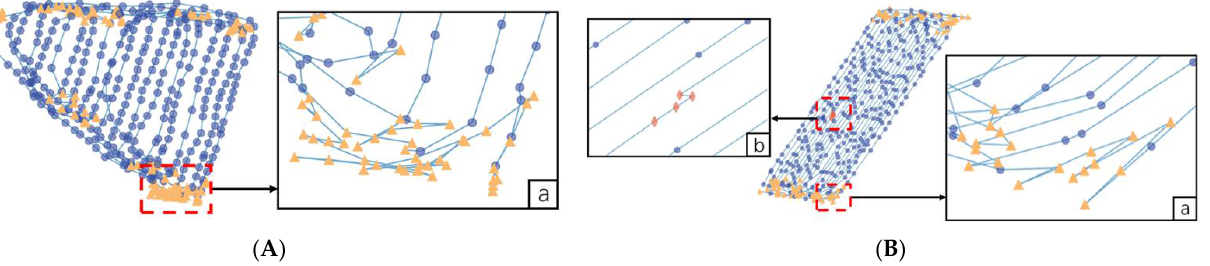
Figure 8. Trajectory identification results of rice and corn. ( A ) Rice harvesting trajectory; ( B ) corn harvesting trajectory. ( a ) Turning trajectory identification result. ( b ) Abnormal working trajectory identification result.